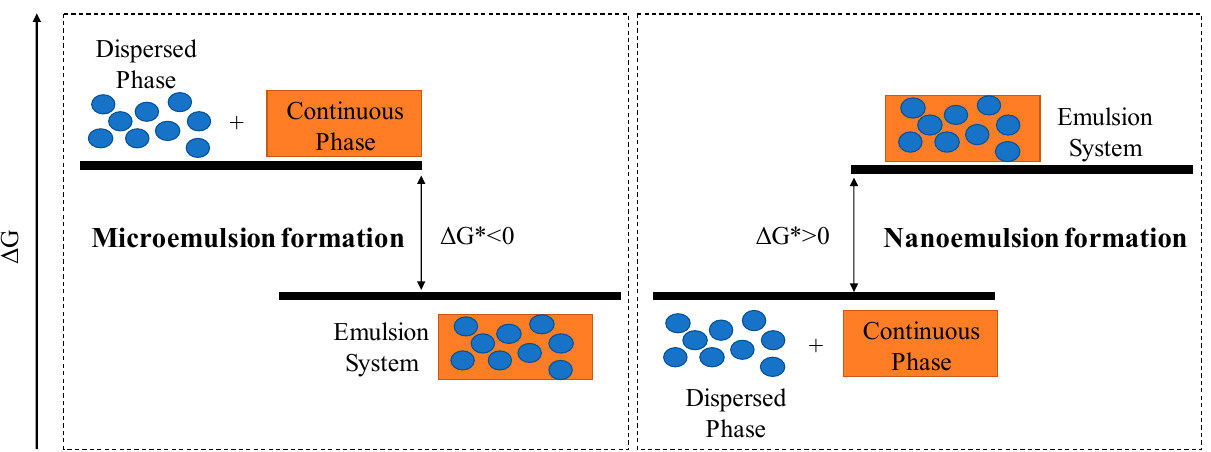
Figure 1. Comparison of the diagrams for the development of microemulsions and nanoemulsions, where ∆ G* is the process activation energy.